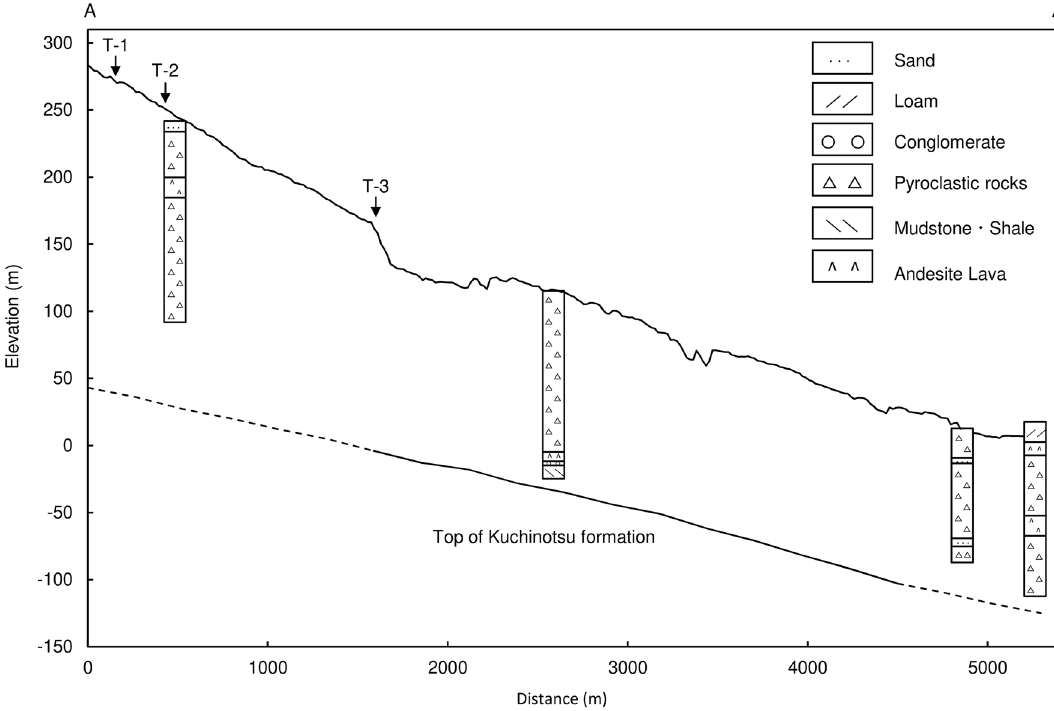
Figure 2. Geological cross section of line A-A’ in Fig.